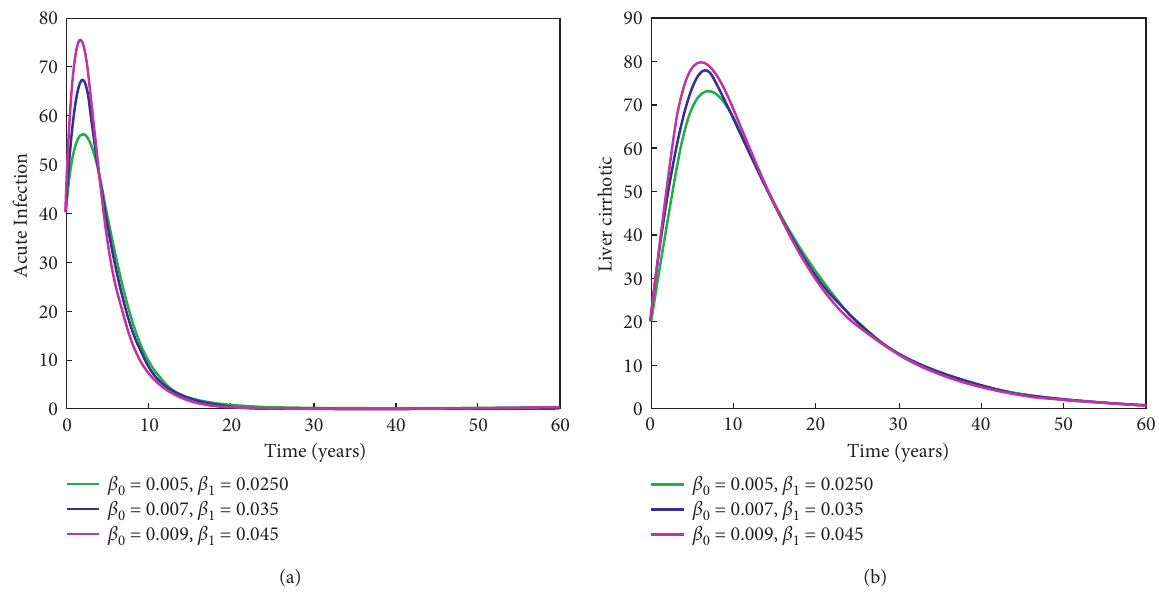
Figure 7: The simulation results of $I(t),$ and $C(t)$ with various mean transmission coefficients β the remaining parameters